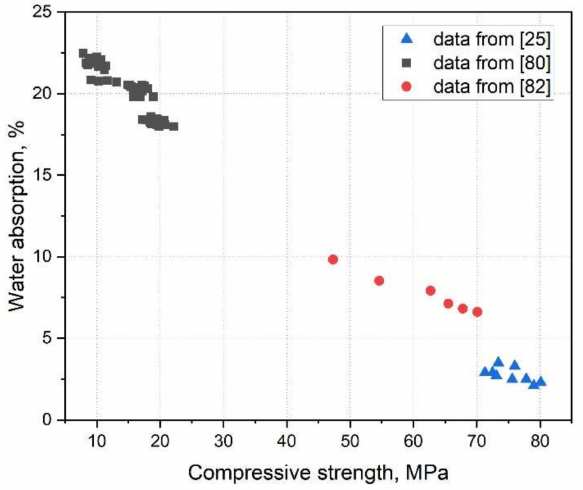
Figure 4. Correlations of water absorption with compressive strength (data from